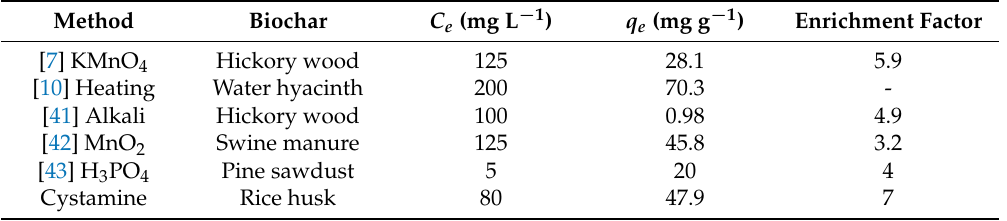
Table 5. Comparison of the modification method obtained to the proposed methods in the